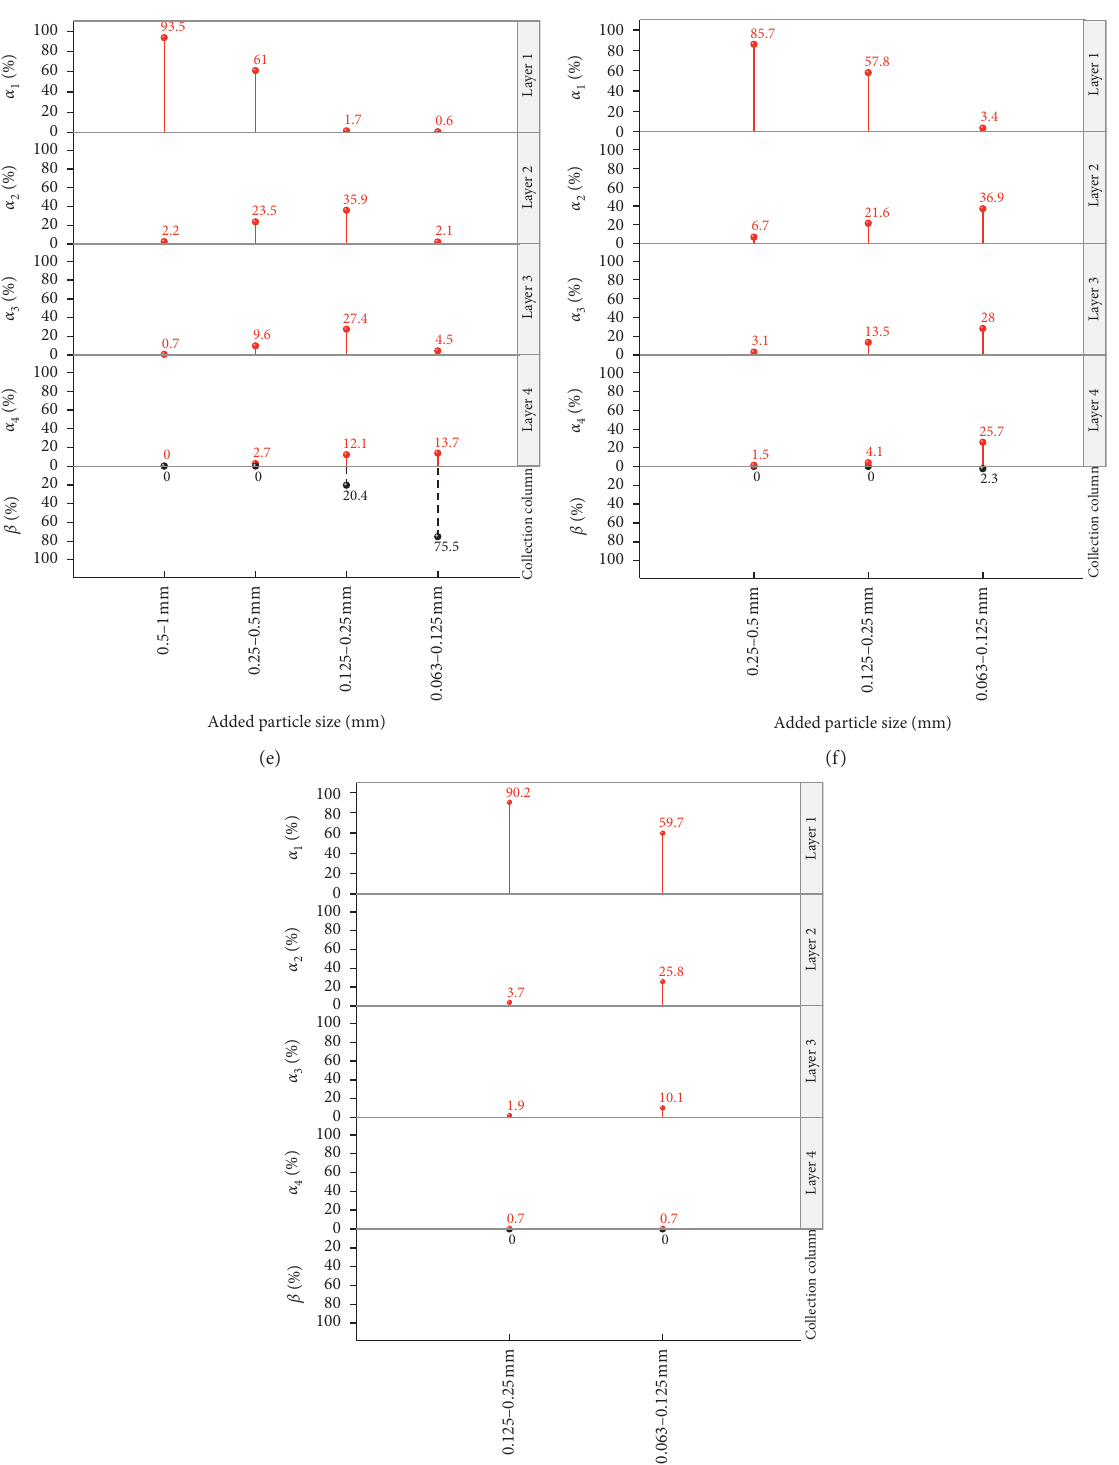
) × 100%; m i is the mass of the incoming particles of 0 ) × 100%; and m m is the mass of incoming 0